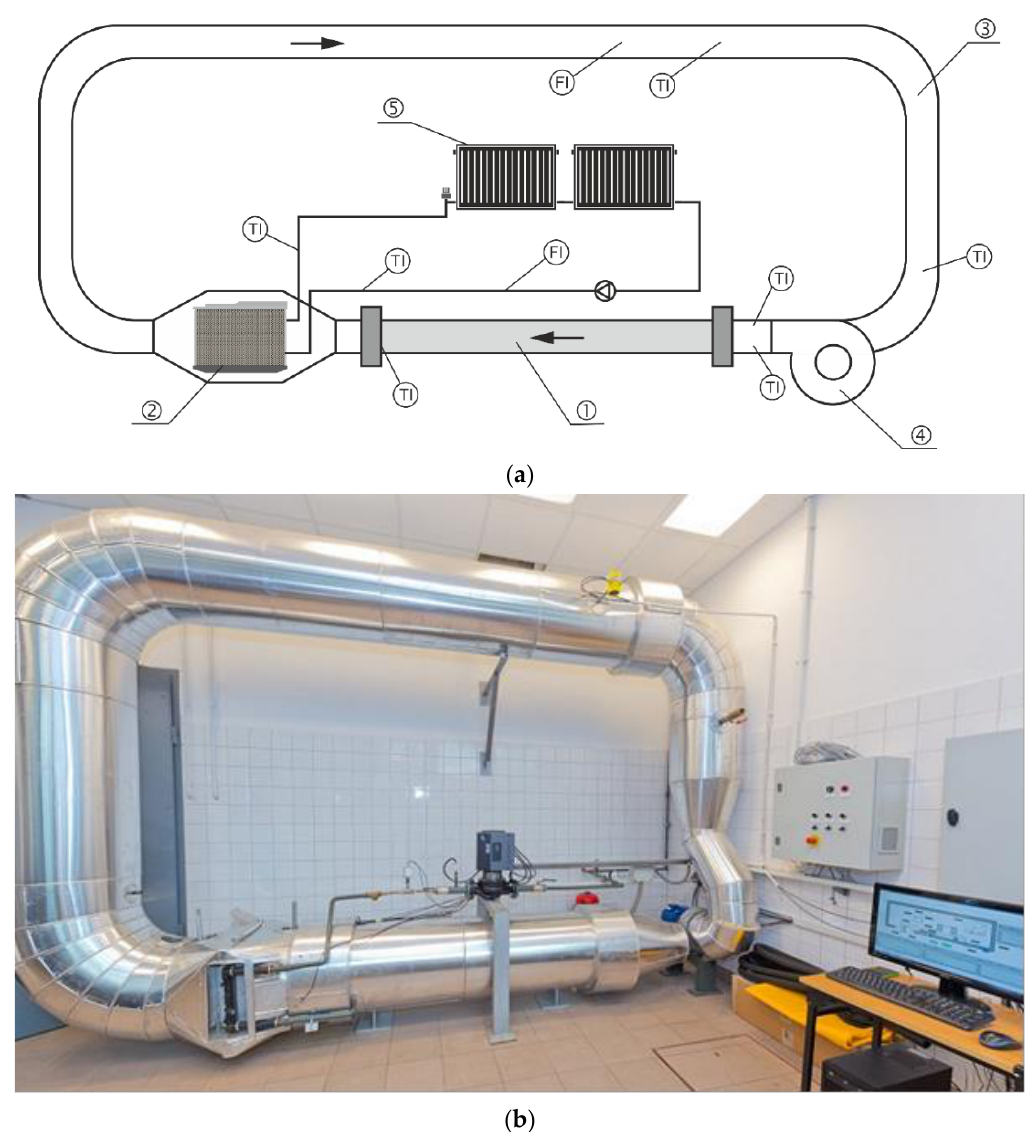
Figure 2. Test rig for a hybrid electric–water heating system for a building: ( a ) flow system of the test stand; ( b ) general view of the test stand. , Ceramic bed heat accumulator; , air–water heater (plate-finned and tube heat exchanger); , reversal duct; , forced draft fan; , water-heating radiators; FI, flow rate meter; TI, pre-calibrated thermocouples.